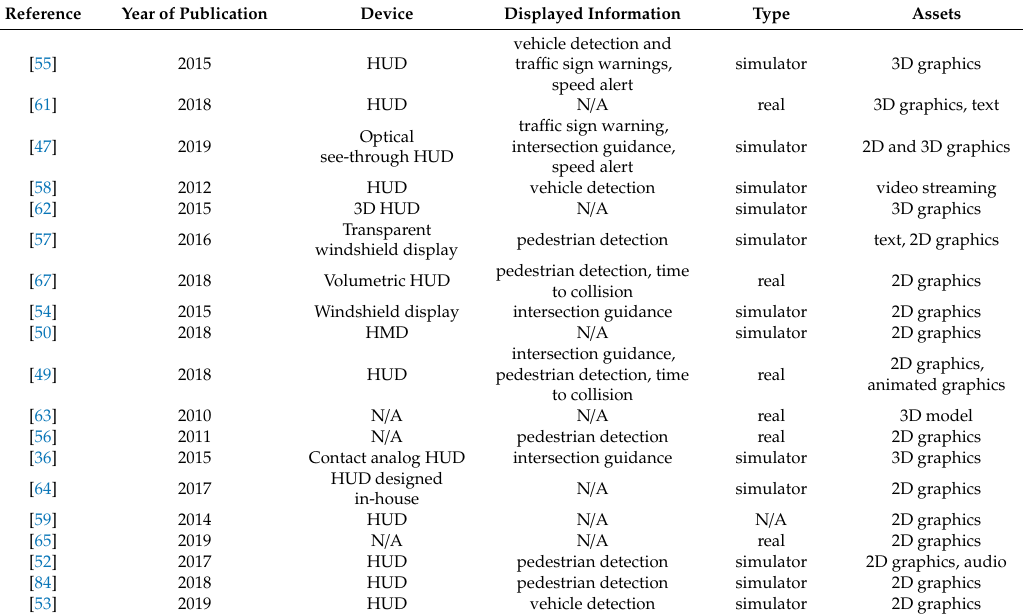
Table 2. General characteristics of AR application that are related to